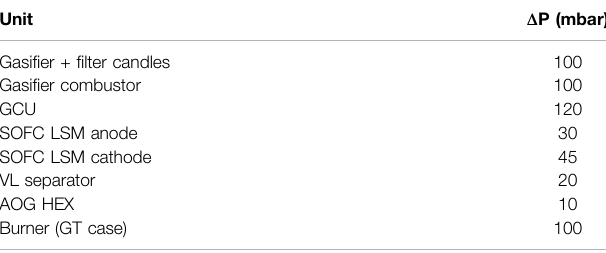
TABLE 1 | Pressure losses per unit in the Bio-SOFC plant (consortium data). VL: vapor – liquid.